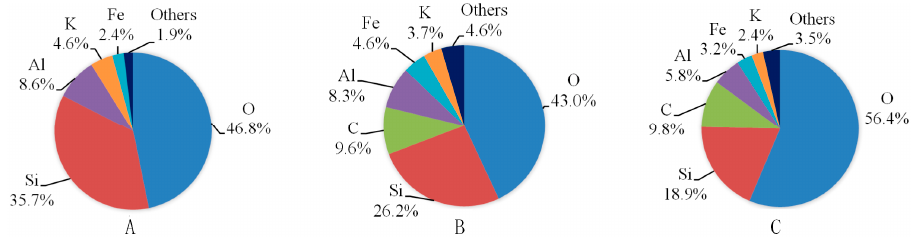
Figure 5. Chemical element composition by EDS analysis. ( A ) is for sample without saturation; ( B ) is for sample with water and gaseous CO 2 saturation and ( C ) is for sample with water and SC-CO 2 saturation.